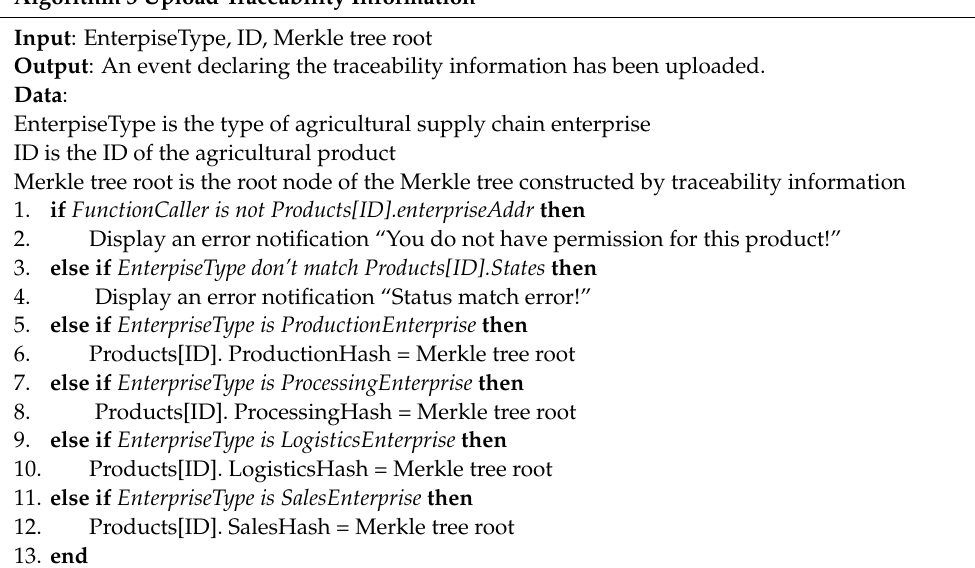
Algorithm 3 Upload Traceability